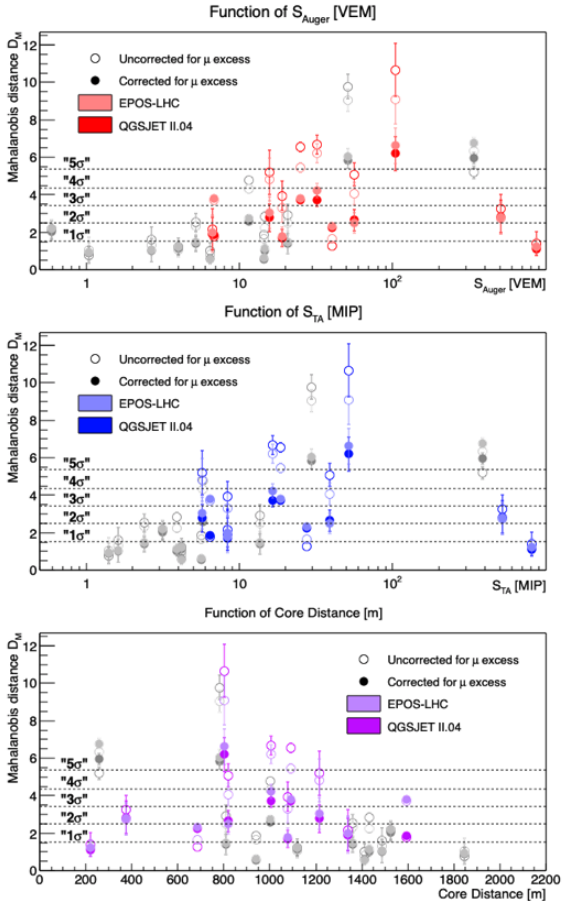
Figure 7. Mahalanobis distance for all the reconstructed events in TA as a function of S Au g er [VEM] (top), S TA [MIP] (middle) and core distance (bottom) for two di ff erent hadronic models. The grey points show the events that did not pass the additional quality cuts (see text for